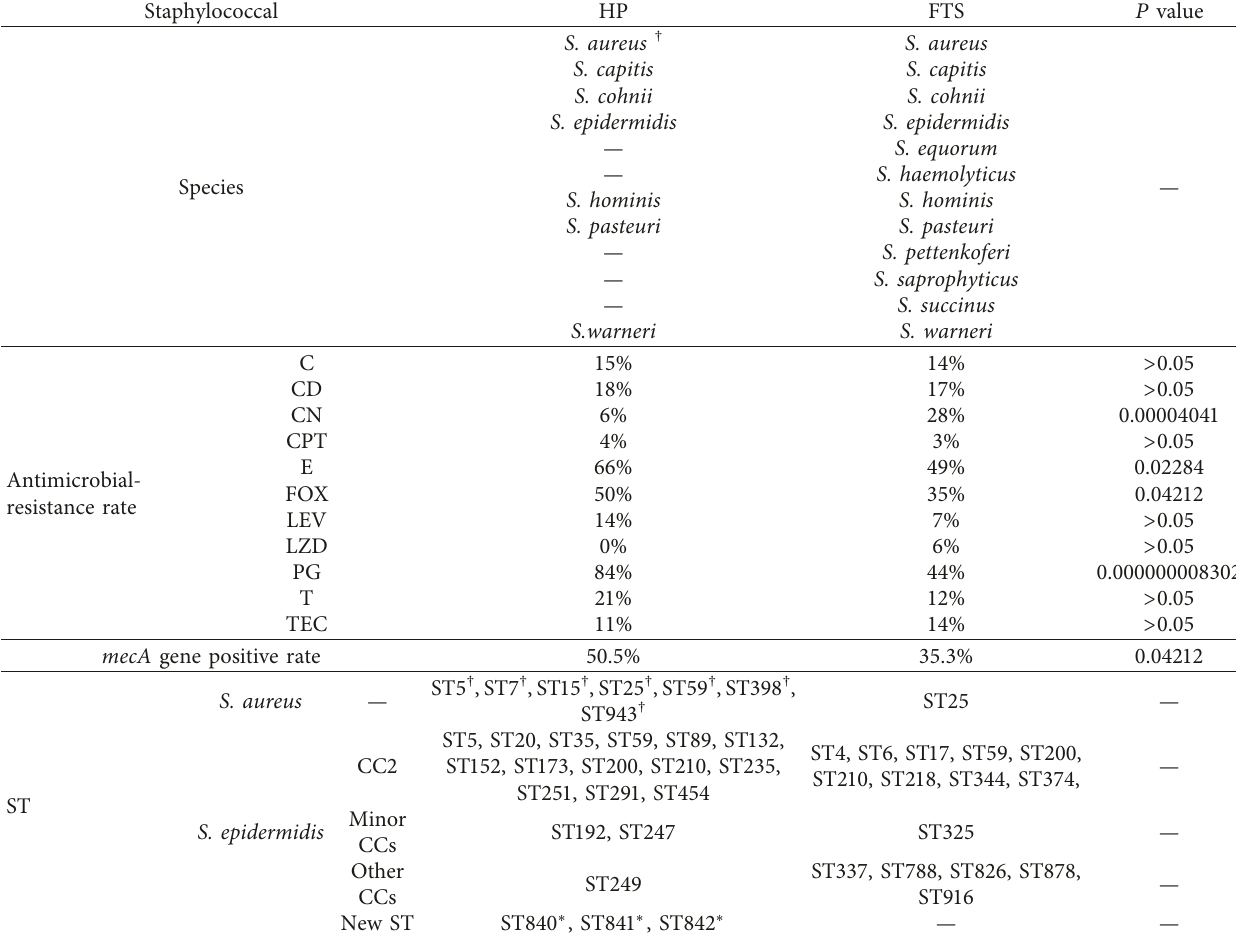
Table 3: Comparative profiling of staphylococcal species, antimicrobial resistance, mecA gene carriage, and STs of staphylococci recovered from hospital personnel and frequently touched